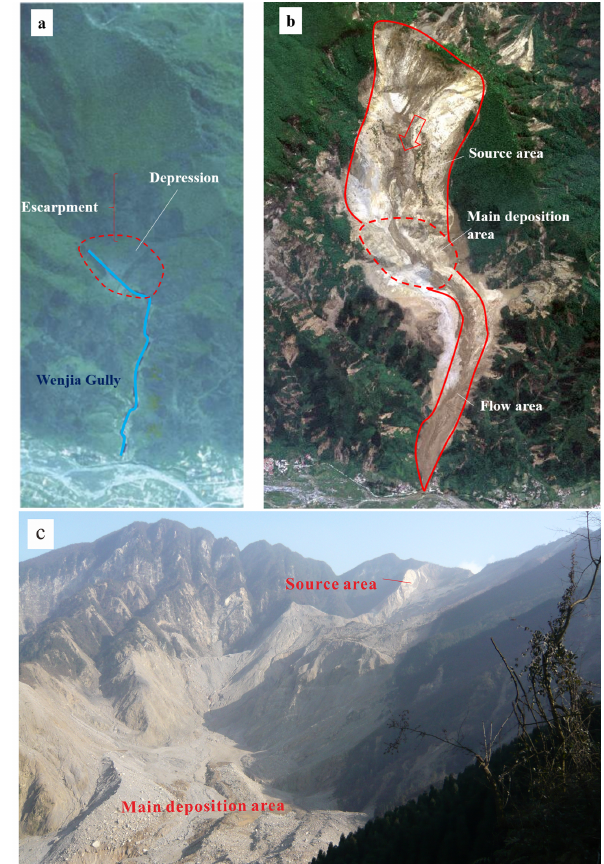
Figure 10. Sketch map of flow capacity of channel affecting on the travel distance of the Wenjia Gully channelized rock avalanche: (a) before the earthquake; (b) after the earthquake; (c) photo taken on deposition platform after the earthquake. The red arrow shows the sliding direction of source mass. The red dotted line in (a) indicates the original depression on the travel path of the rock avalanche, where debris deposition of about 30millionm 3 was stored after the earthquake (shown in b ); more detailed information is shown in (c)